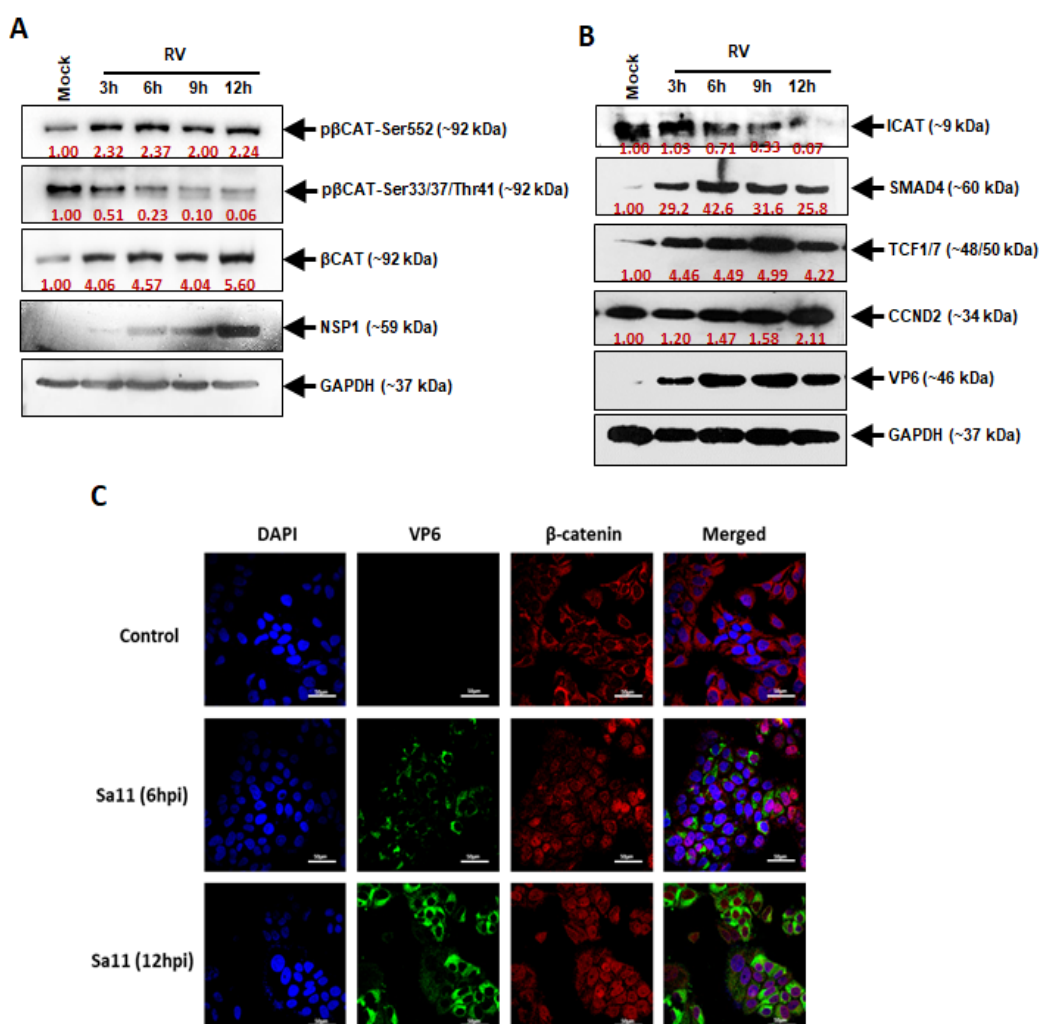
Figure 1. RV infection triggers β -Catenin accumulation. Cells infected with RV were harvested at different time points followed by protein expression analysis by Western blotting and Confocal microscopy techniques. ( A ) RV upregulates β -catenin expression during early (3–12 h) hours of infection. Expression of phospho β -catenin Ser37 downregulated in RV infected cells. Expression of phospho β -catenin Ser552 upregulated in RV infected cells; ( B ) Changes in the expression levels of different regulators of the Wnt/ β -catenin cellular signaling pathway. Expression of ICAT downregulated in RV infected cells. SMAD4 is activated during RV infection and acts as an attenuator of β -catenin proteasomal degradation. The downstream molecule of β -catenin and SMAD4, TCF1/7 and CCND2 are also activated during RV infection; ( C ) Phosphorylation at Ser552 and destabilization of Ser37 induces β -catenin accumulation in the cytoplasm and nucleus as evident from IF imaging. Scale bars: 50 μ m.